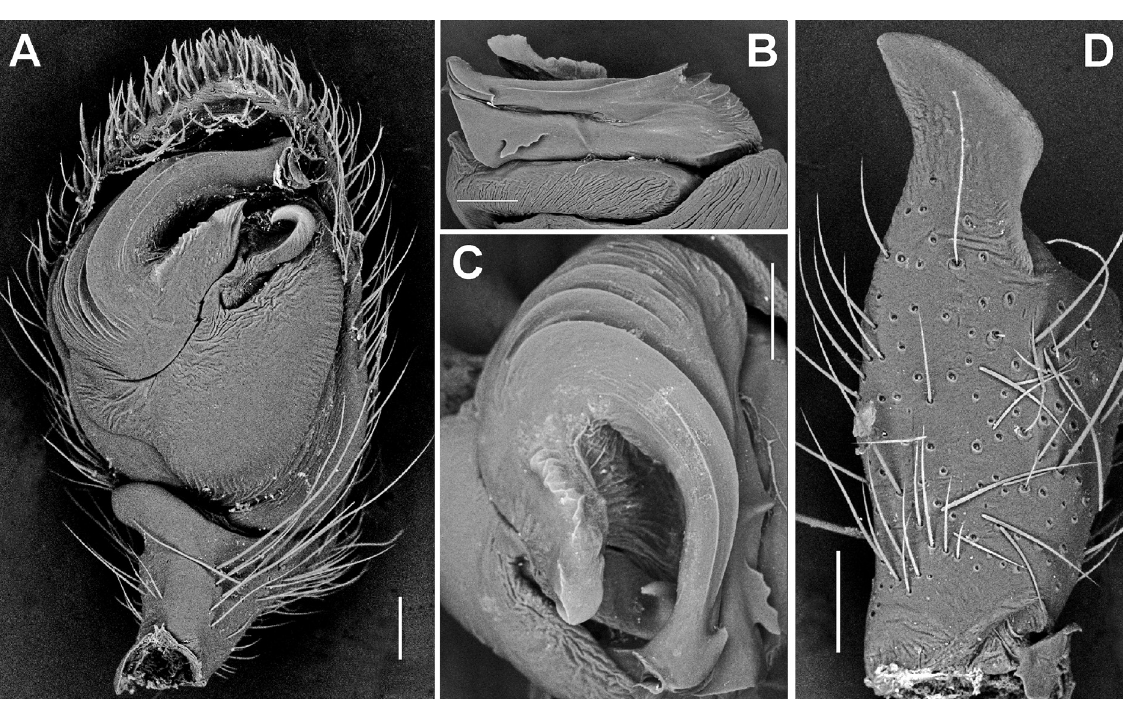
Fig. 13. Haplodrassus qashqai sp. nov., paratype, ♂ from Lorestan Province (MHNG), SEM graphs of the male palp. A . Ventral view. B . Embolus, dorsal view. C . Apical portion of bulb. D . Tibial apophysis, retrolateral view. Scale bars: 0.1